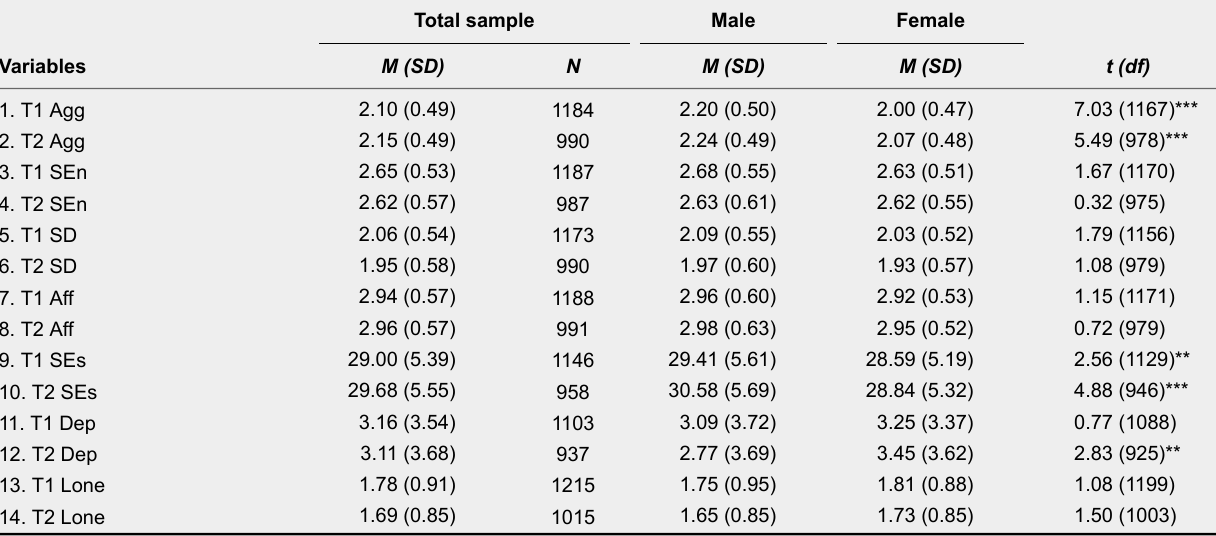
Means (and SDs) for the Total Sample and Males and